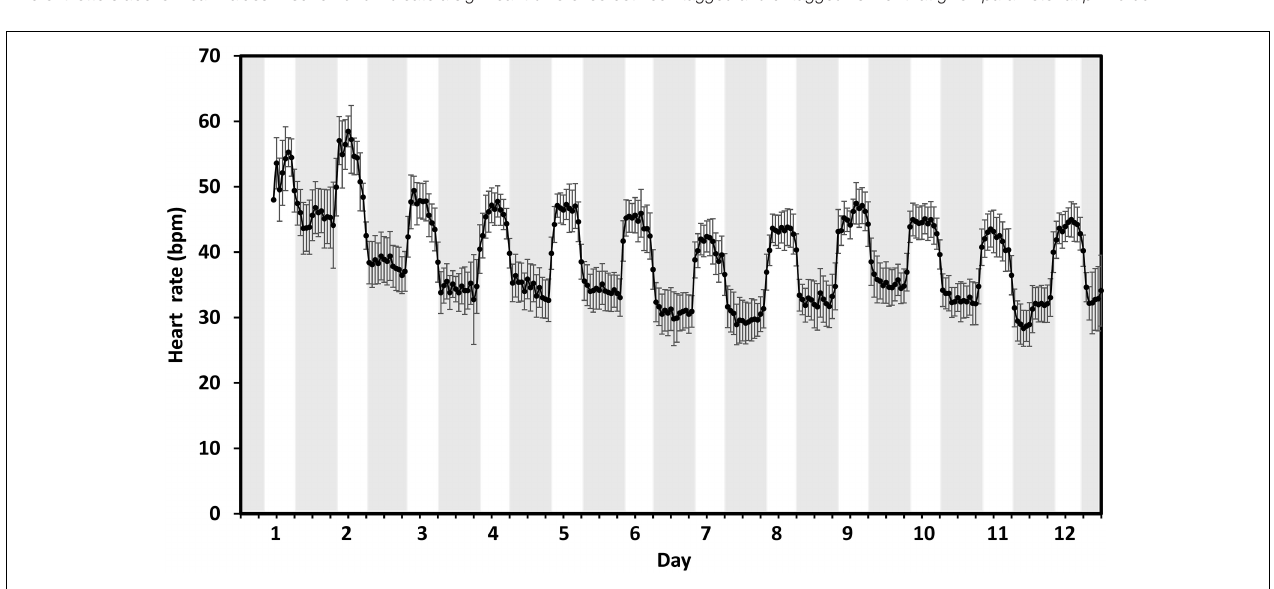
using a Bonferroni corrected p < 0.017 showed that fish had